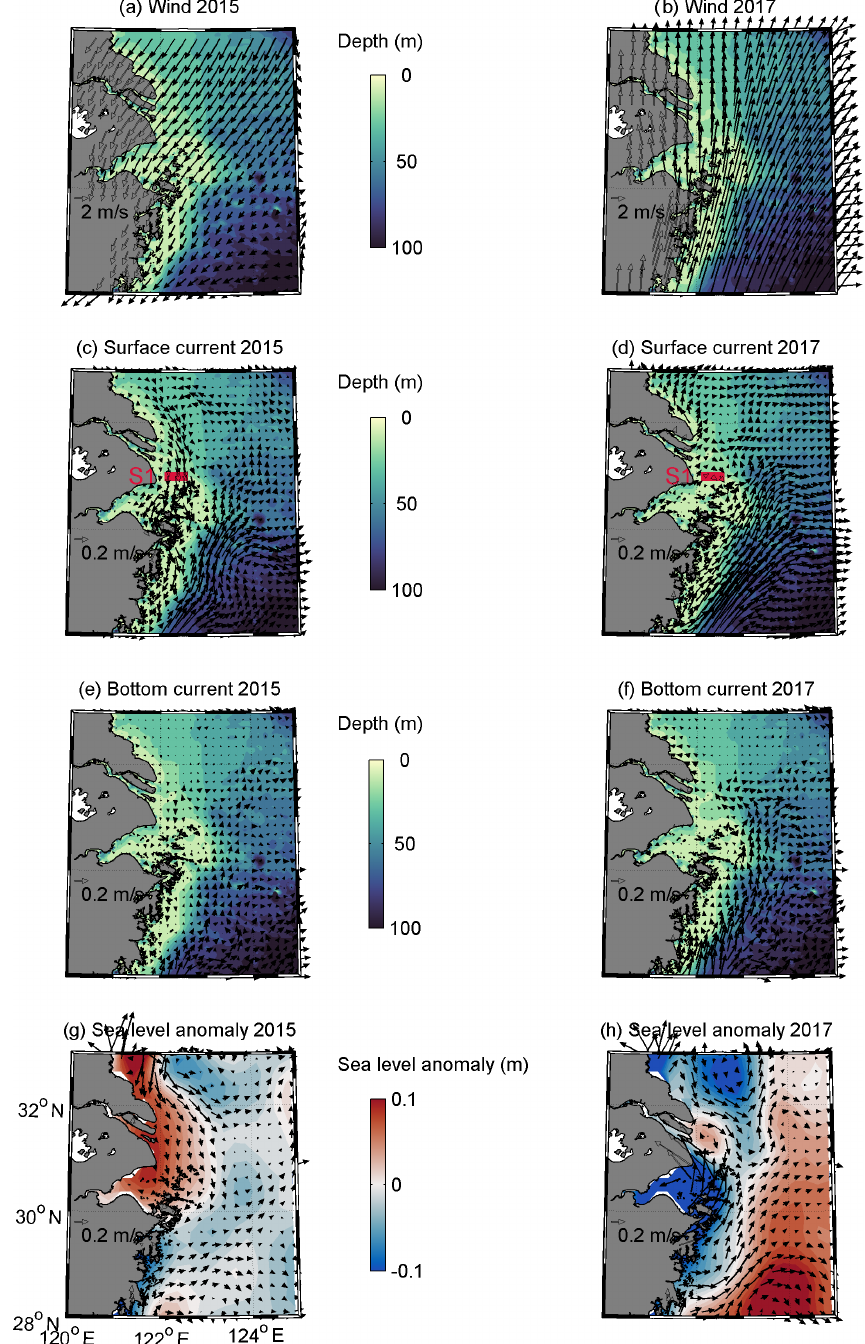
Figure 8. Maps of mean wind ( a–b , ms − 1 ), simulated surface current ( c–d , cms − 1 ) and bottom current ( e–f , cms − 1 ) in the sea bottom depths down to 100m during the 7d period before the CTD surveys. Bottom bathymetry is shown as a background in (a) – (f) . Red lines in (c) and (d) show section S1, where current time series (presented in Fig. 10c) were calculated. Every fourth current vector is shown only in (c) – (f) . Mean sea level anomaly (m) as contours and geostrophic velocities (cms − 1 ) as vectors derived from satellite altimetry during the surveys are shown in (g) – (h)